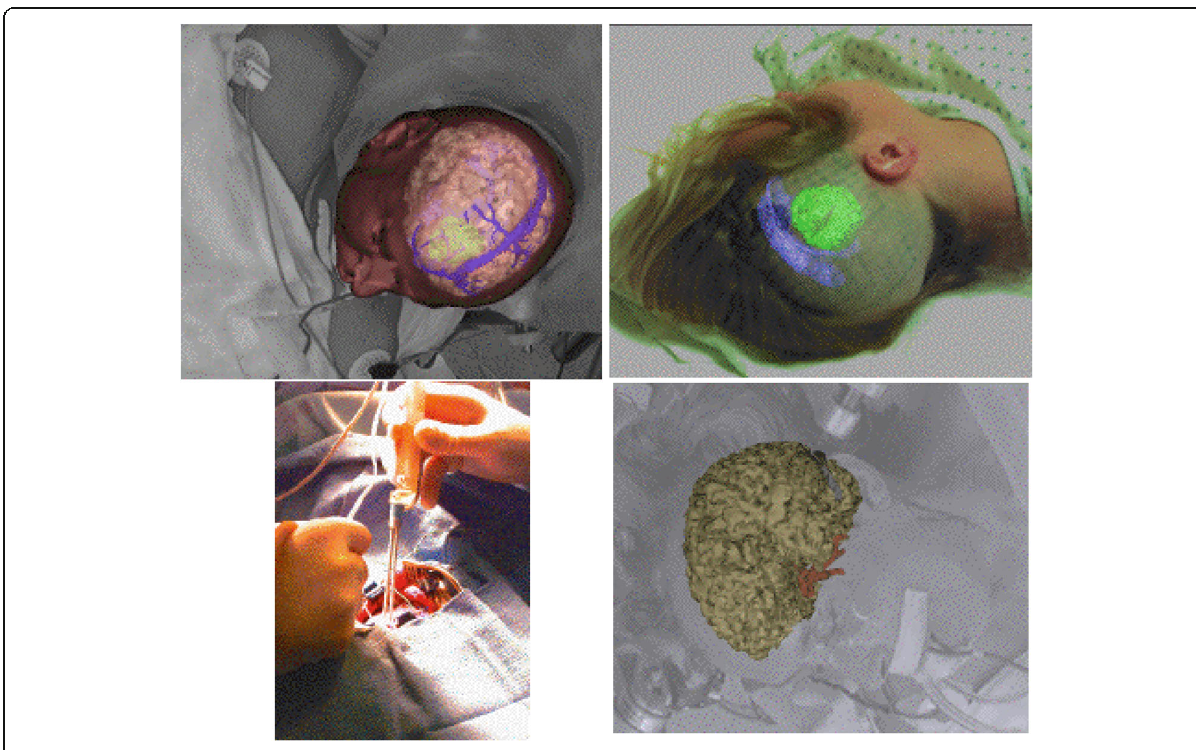
Fig. 6 Brain imaging and brain surgery using AR